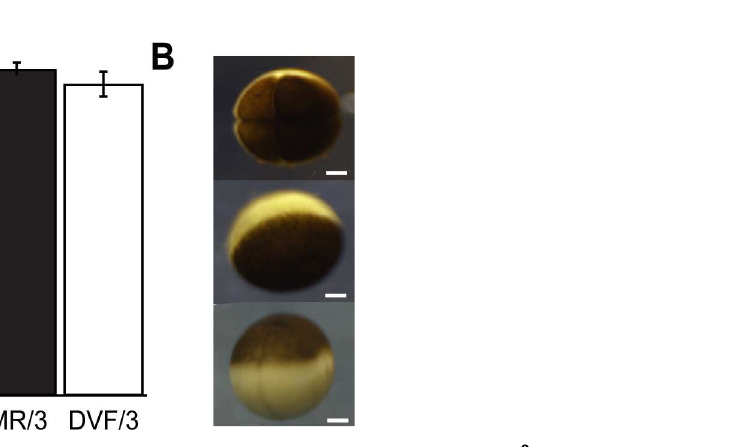
Fig 1. X . laevis embryos developed normally in the absence of added Ca 2+ . (A) Averaged percentageof embryos that developedcleavagefurrows from eggs inseminated in MR/3 or DVF/3 (N = 153–160eggs in 5 experimental trials). (B) Representative images of a developed X . laevis embryo at the 4-cell stage (top), an undivided egg (middle), and an embryo with faint cleavagefurrows (bottom); scale bar = 250 μ m.